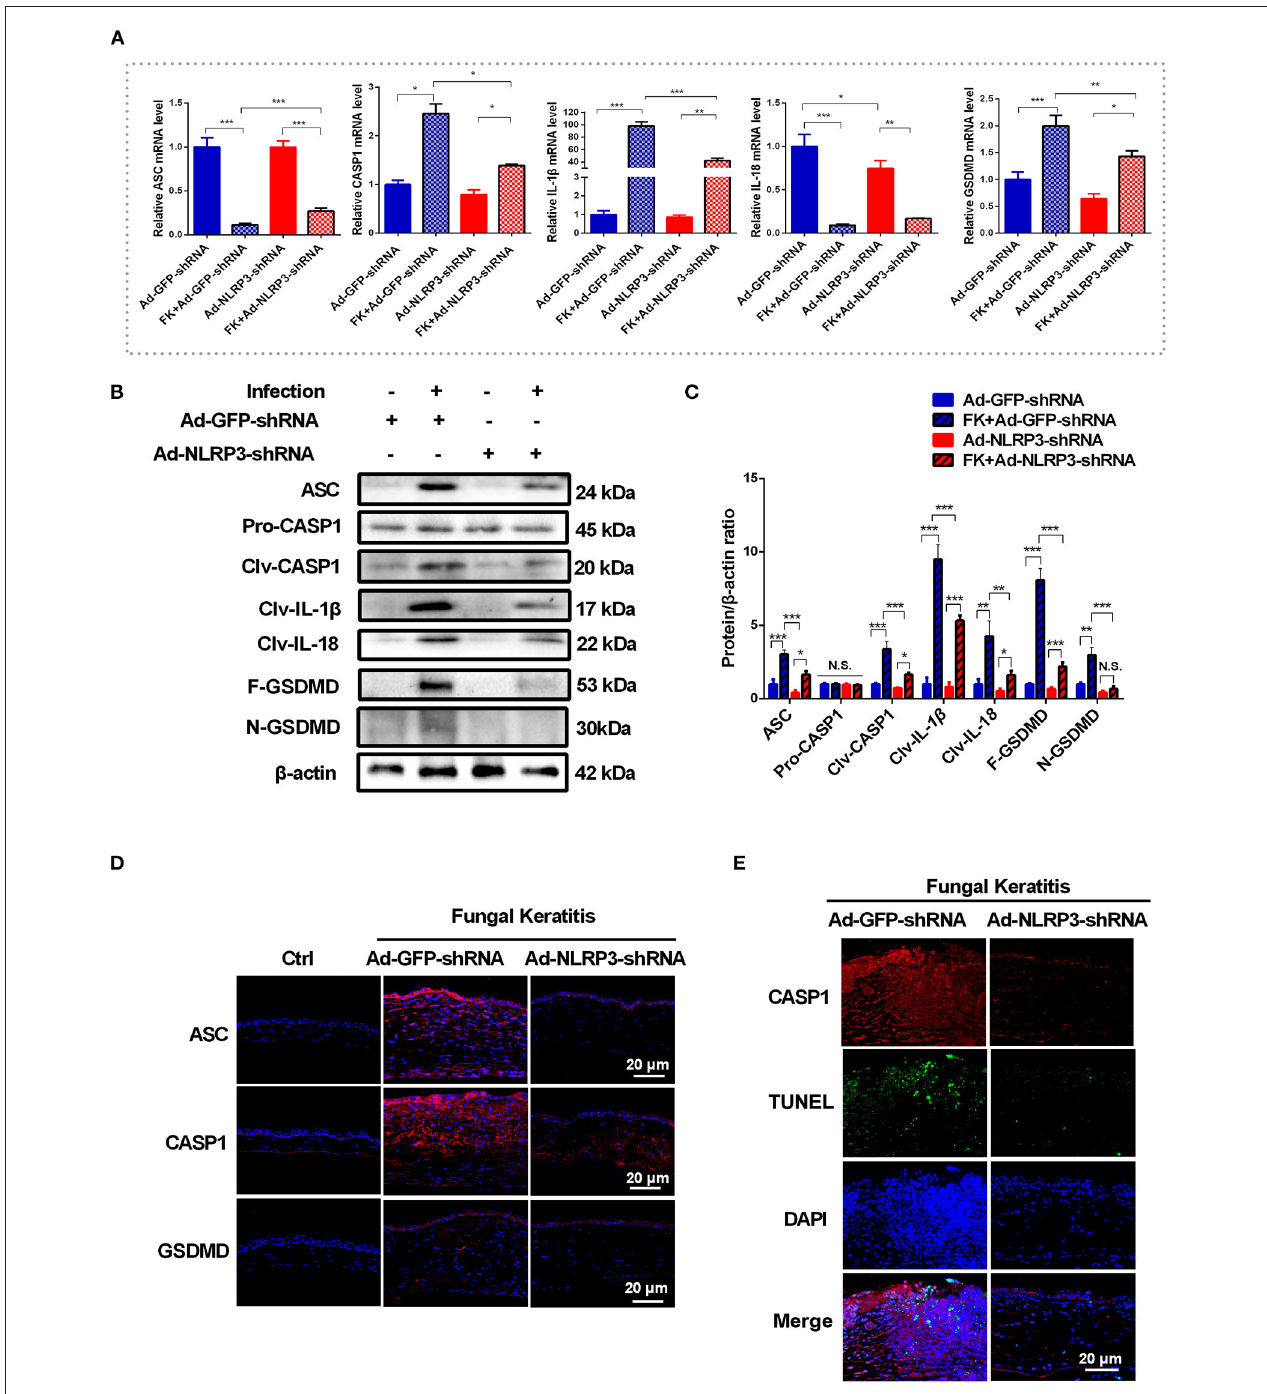
FIGURE 4 | NLRP3 knockdown attenuates the pyroptosis in mouse C. albicans keratitis. (A–C) RT-qPCR analysis and western blot showing the mRNA and protein levels of pyroptosis-related molecules in C. albicans -infected corneas pretreated with Ad-GFP-shRNA and Ad-NLRP3- shRNA compared with mock controls ( n = 3). (D) Immunofluorescence staining of ASC, CASP1 and GSDMD in C. albicans -infected corneas pretreated with Ad-GFP-shRNA and Ad-NLRP3- shRNA compared with mock controls ( n = 3). (E) Double-immunofluorescence staining of CASP1 and TUNEL in the mice cornea of Ad-NLRP3-shRNA group compared with the Ad-GFP-shRNA group ( n = 3). Scale bar = 20 µ m; magnification 400 × . FK: fungal keratitis. CASP1: caspase-1; Clv-CASP1:cleaved CASP1; Clv-IL-1 β :cleaved IL-1 β ; Clv-IL-18:cleaved IL-18; F-GSDMD: p53 form of GSDMD; N-GSDMD: cleaved p30 form of GSDMD. All values are presented as mean ± SEM. * p < 0.05; ** p < 0.01; *** p <